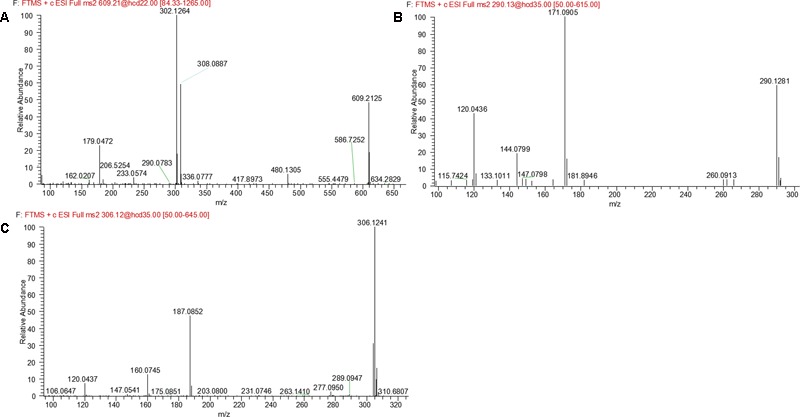
MS2 spectra of M14 and M15 (A), M16 (B), and M17–M19 (C).